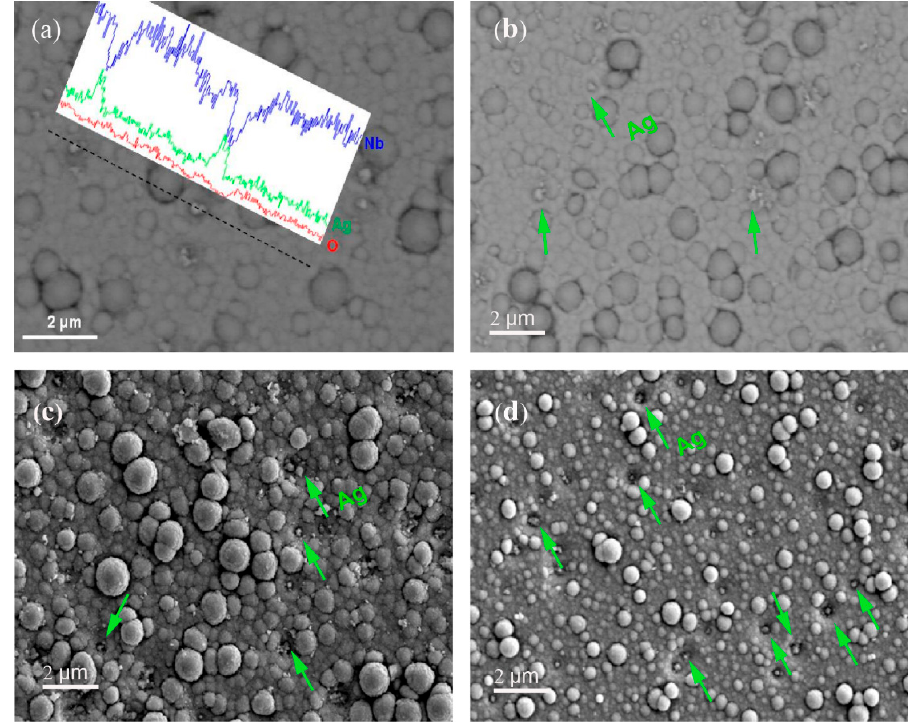
Figure 4. Back scattered electron images ( a , b ) and scanning electron microscopy (SEM) observations ( c , d ) of NbCN-Ag composite films with various Ag content: ( a ) line scan at 2.0 at.% Ag; ( b ) 2.0 at.% Ag; ( c ) 4.6 at.% Ag; ( d ) 12.9 at.% Ag.